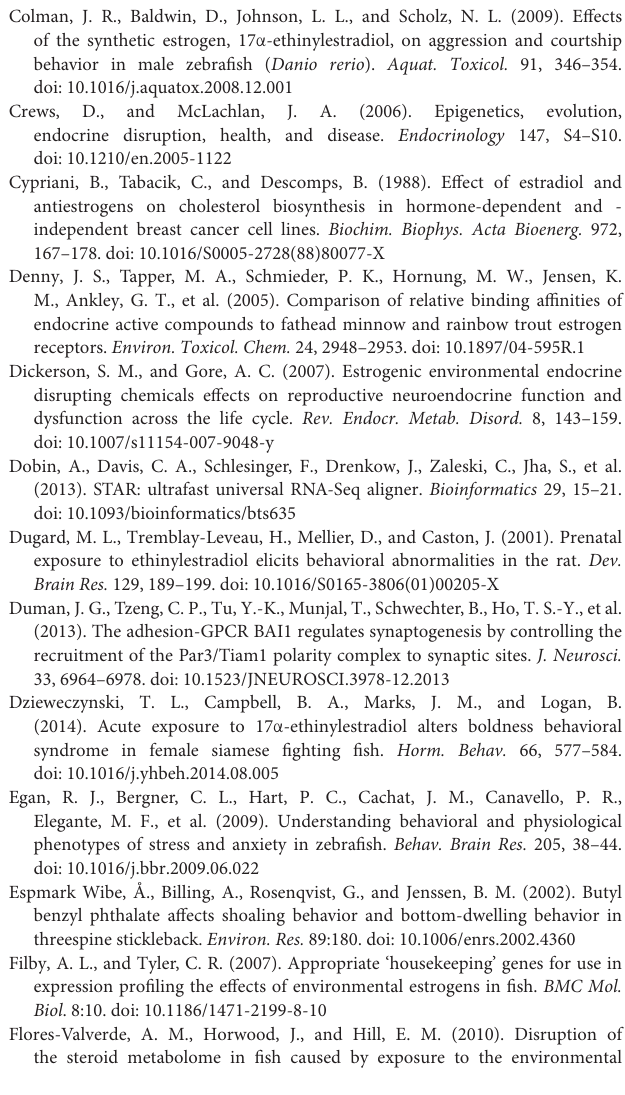
Figure S1 | Experimental set up for behavioral tests seen from the side. (A) Novel tank test. (B) Shoaling test. (C) Scototaxis